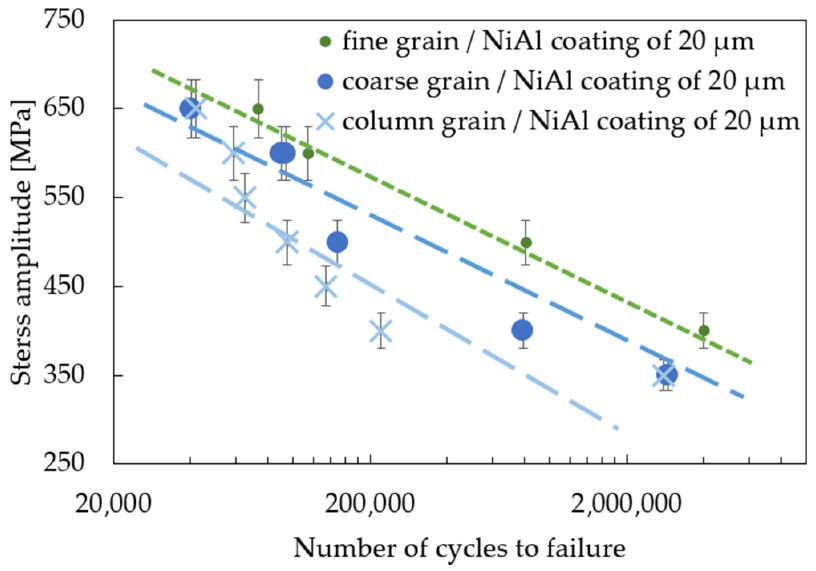
Figure 8. S-N curves for the MAR 247 nickel-based superalloy coated with 20 µm-thick NiAl.